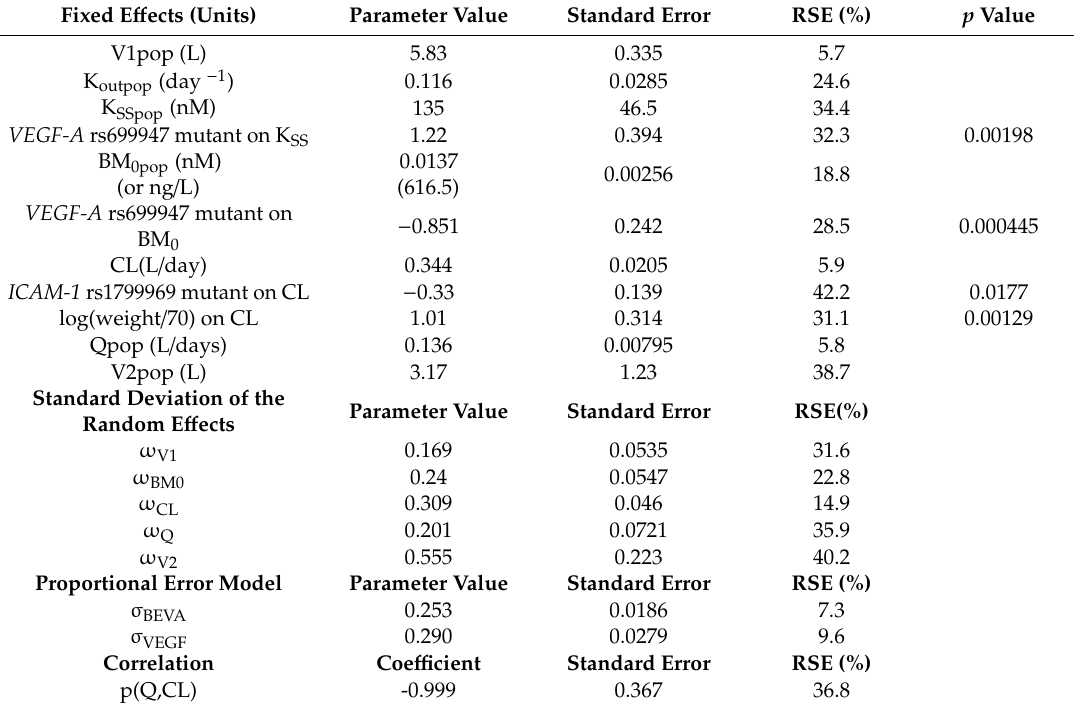
Table 2. Parameter estimates of the binding quasi-steady state (QSS)